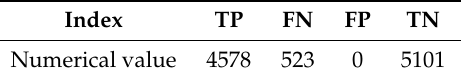
Table 14. Forecast indices value.